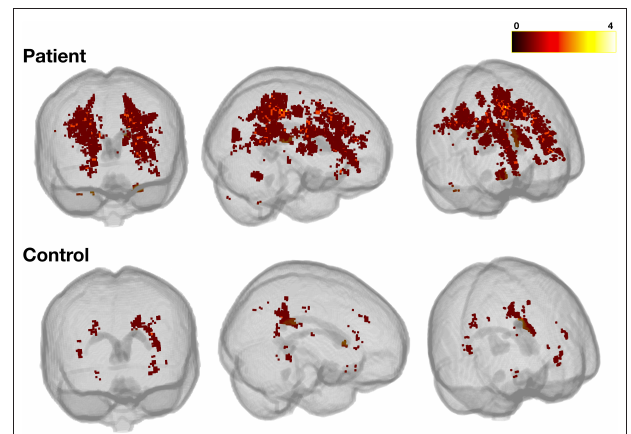
FIGURE 6 | Heatmap for liberally-defined SCI. Showing the distribution and frequency of lesions for the liberal definition in patients (top row) and controls (bottom row). All lesions were registered to a standard space template (MNI 152) using non-linear registrations from the FSL_anat pipeline (https://fsl.fmrib. ox.ac.uk/fsl/fslwiki/fsl_anat). The color bar shows the number of participants with lesions in a particular